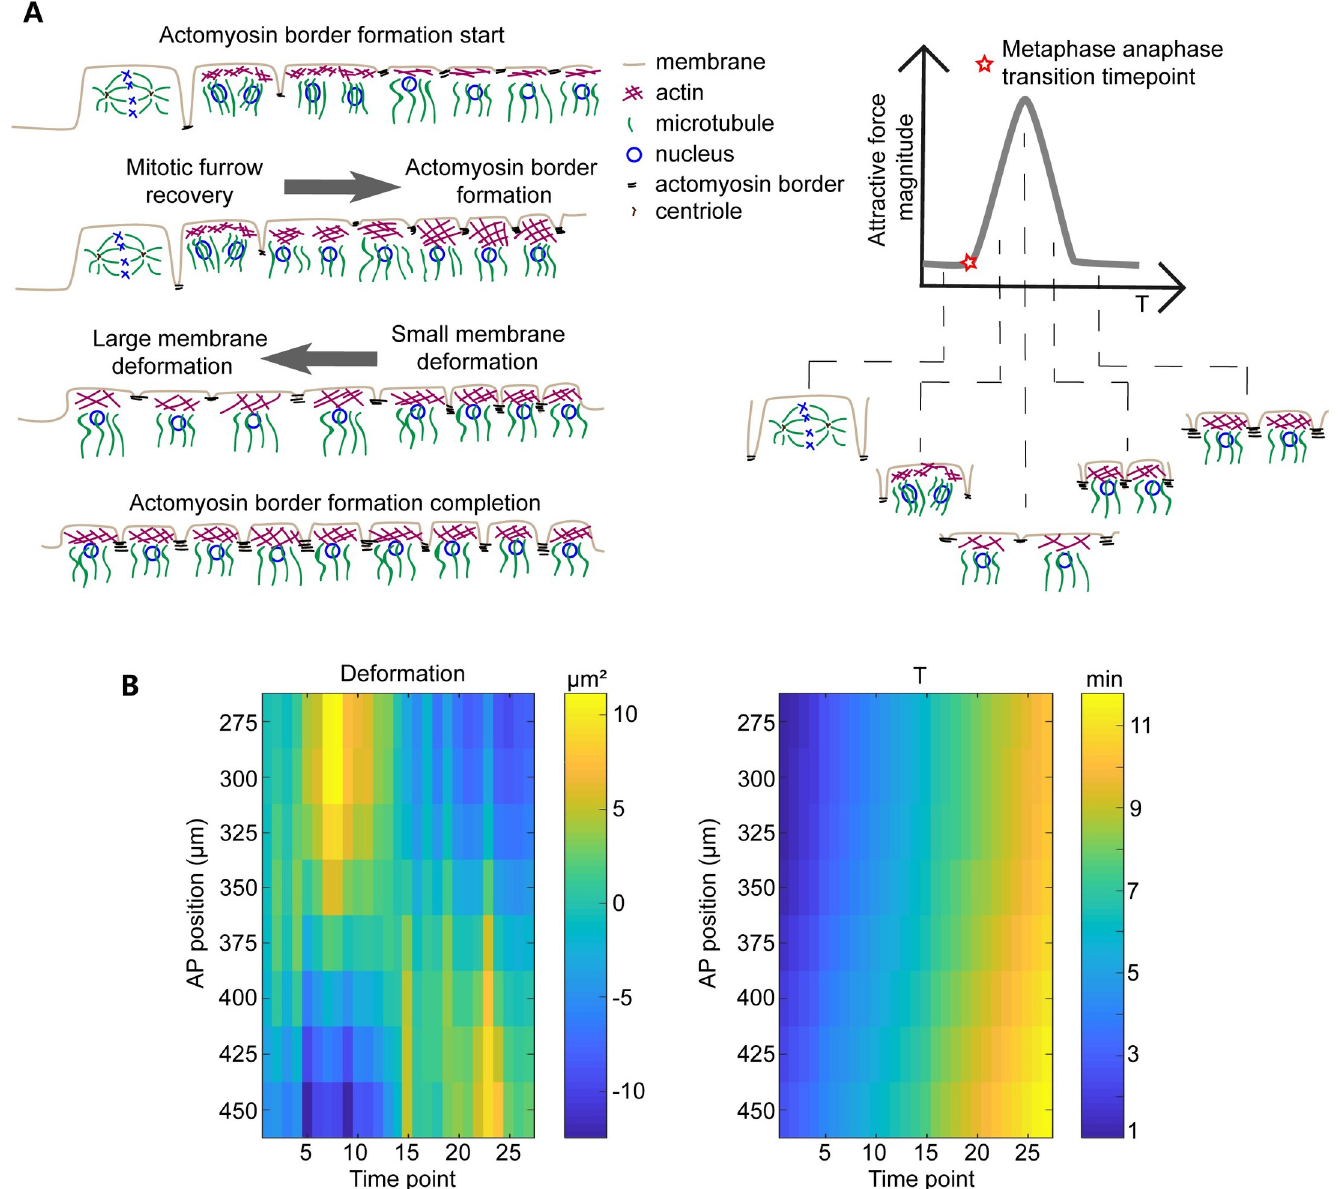
Fig 7. Molecular basis of the F a force field from the MFLNN model. (A) The relationship between biological molecular dynamics and the F a force. Each nucleus dynamically changes between five typical states during each nuclear cycle: “mitotic furrow state”, “mitotic furrow recovery state”, “flat membrane with lager membrane deformation and less myosin II state”, “actomyosin border formation with small membrane deformation state”, and “actomyosin border formation completion state”. The relationship between the states and the F a force field is shown in the right panel. The corresponding nuclear motion process is shown in the left panel. (B) Heat maps of the calculated average cell area (the Voronoi area of each nucleus) variation relative to the original cell area (left) and the nuclear age (right) after the onset of anaphase 12. experimental results seem to support this mechanism. For example, the computed cell defor- mation is larger in the middle of the embryo than the pole region during the first half period of the standing wave of the AP speed (Fig 7B). And the nuclear collective motion pattern nearly disappears after injecting myosin II inhibitor into the embryo [3], indicating that myosin II